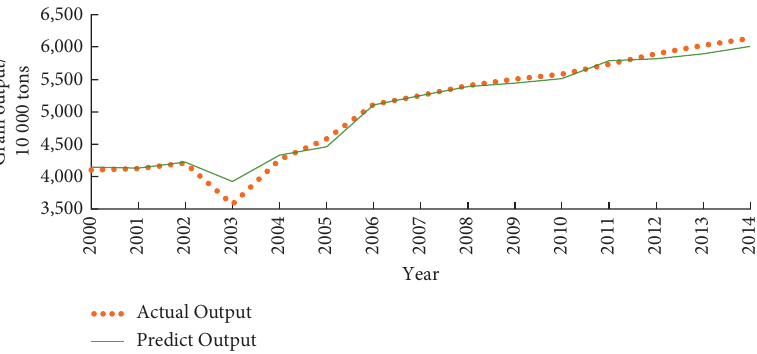
Figure 4: GR-BPNN Model training sample fitting curve.